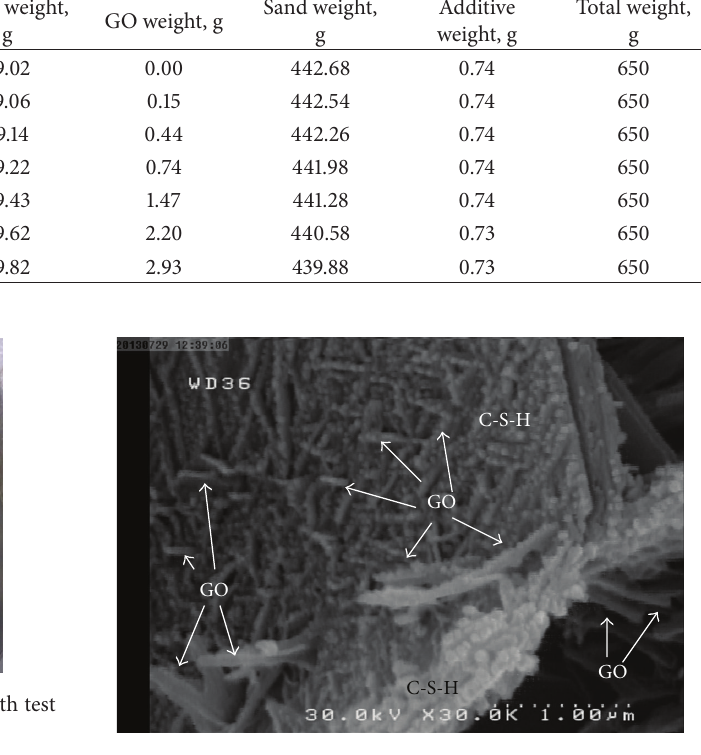
Figure 8: FE-SEM images of cement mortar containing 1.5wt% GO at a scale of 1.0 𝜇 m after 28 days